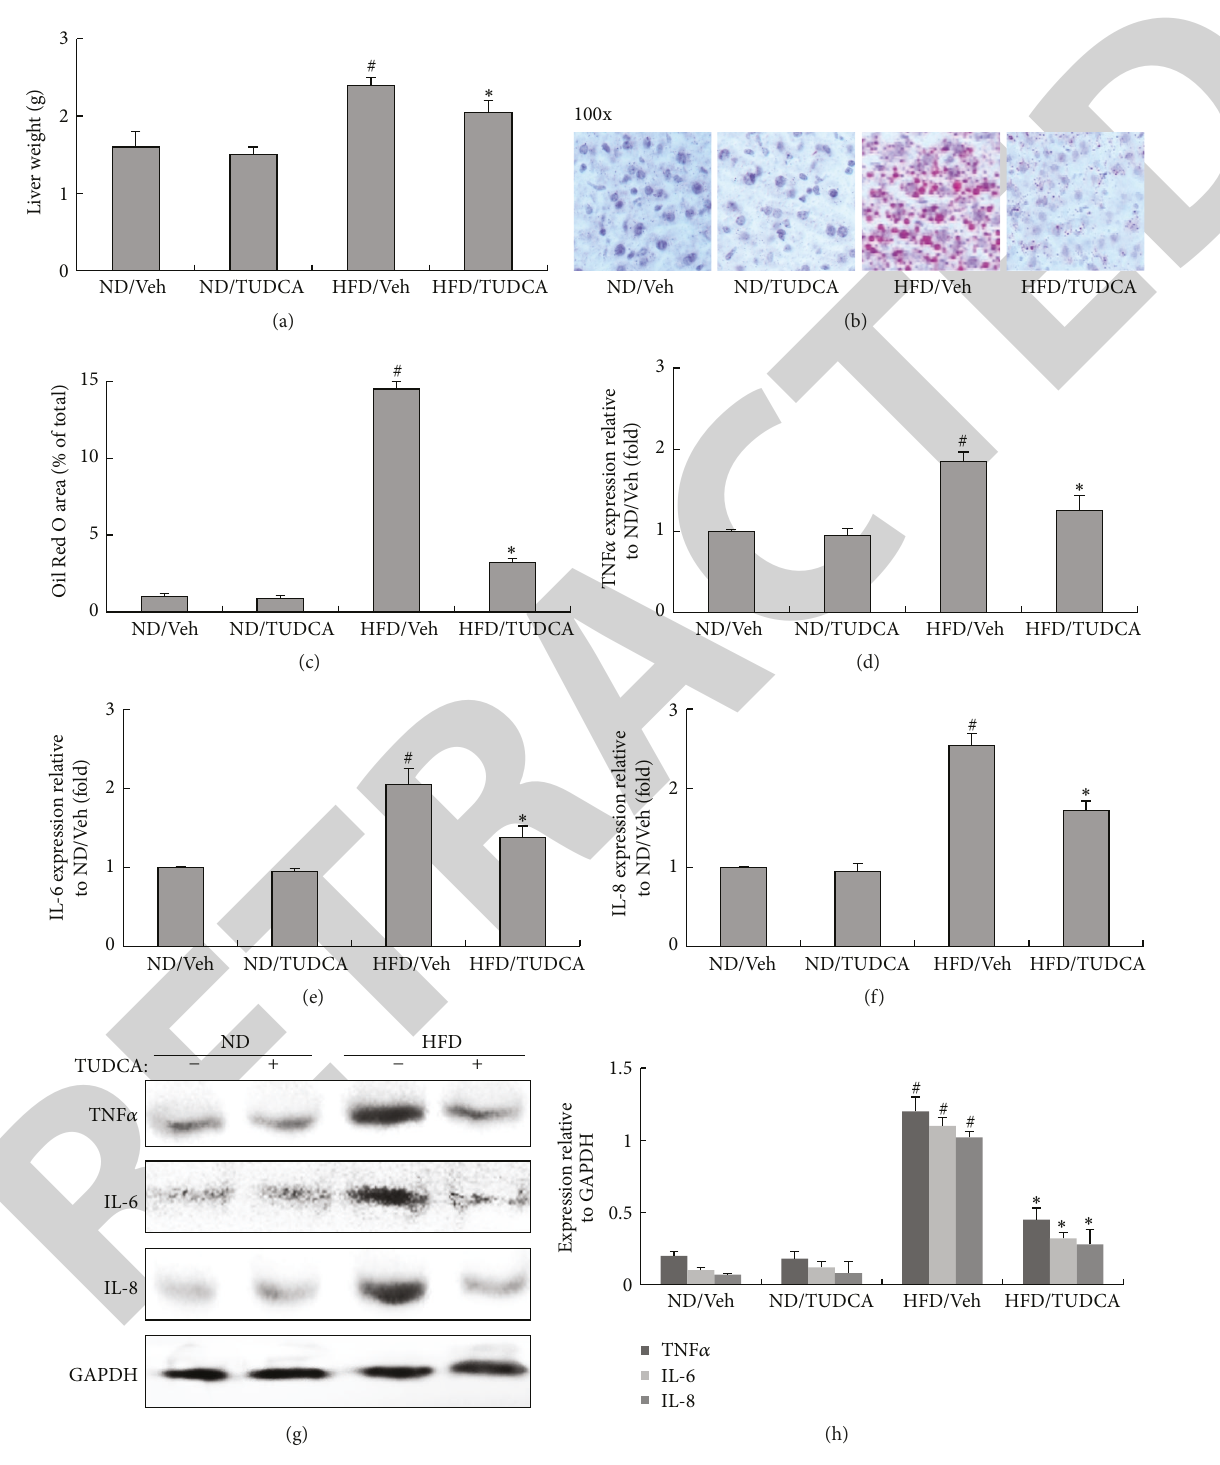
Figure 2: Effects of TUDCA on liver steatosis in obese mice. All analyses were performed in mice fed a normal diet (ND) or a high-fat diet (HFD) for 8 weeks and then injected daily with 500 mg/kg of TUDCA or with vehicle (Veh) for 8 weeks. (a) Liver weight. (b) Oil Red O staining of liver sections (magnification 100x). (c) Histomorphometric quantification of the Oil Red O positive area in liver. (d) Relative expression of TNF 𝛼 in liver (real-time PCR). (e) Relative expression of IL-6 in liver (real-time PCR). (f) Relative expression of IL-8 in liver (real-time PCR). (g) Protein expression of TNF 𝛼 , IL-6, and IL-8 in liver. (h) The relative protein quantity of TNF 𝛼 , IL-6, and IL-8 in liver. The relative quantity of proteins was analyzed using Quantity One software. A representative blot is shown and the data was expressed as mean ± SEM in each bar graph. ∗ 𝑃 < 0.05 (HFD/TUDCA versus HFD/Veh). # 𝑃 < 0.05 (HFD/Veh versus